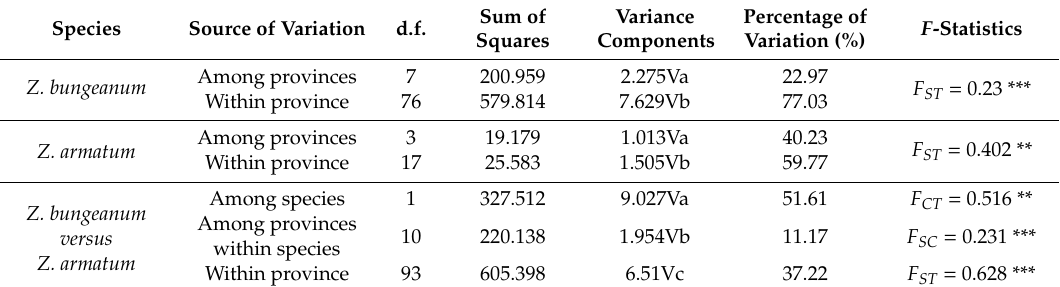
Table 2. Analysis of molecular variance (AMOVA) for 84 accessions of Z. bungeanum in 8 provinces and 21 accessions of Z. aramtum in 4